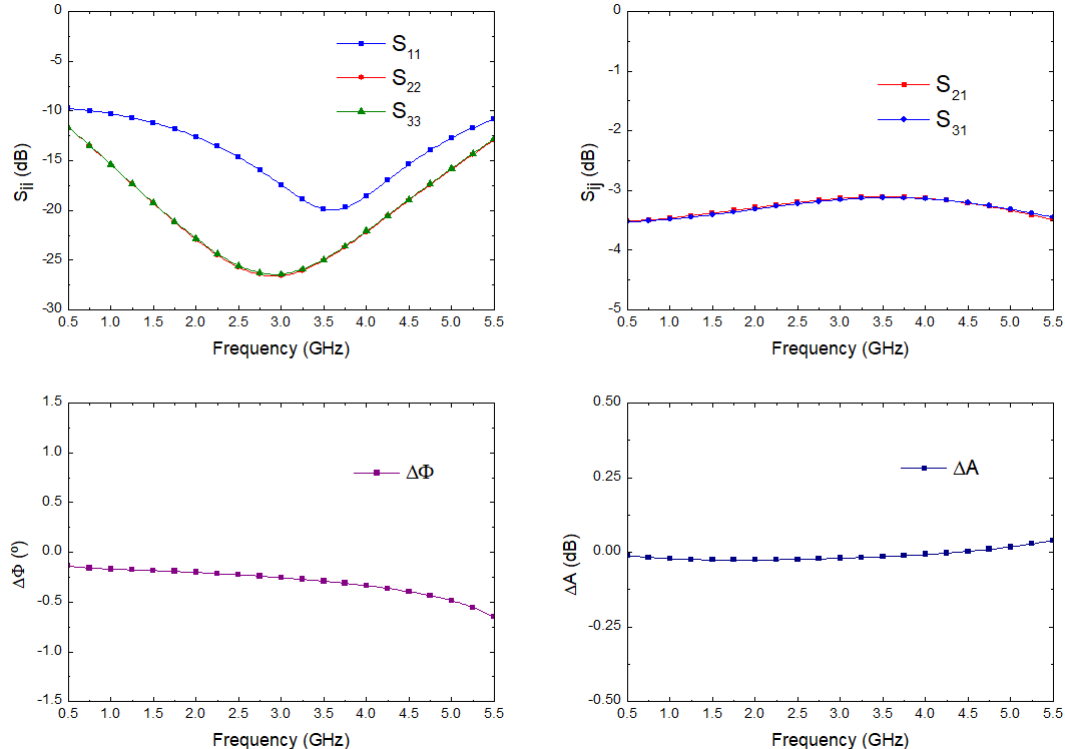
Figure 8. Wilkinson power divider electromagnetic